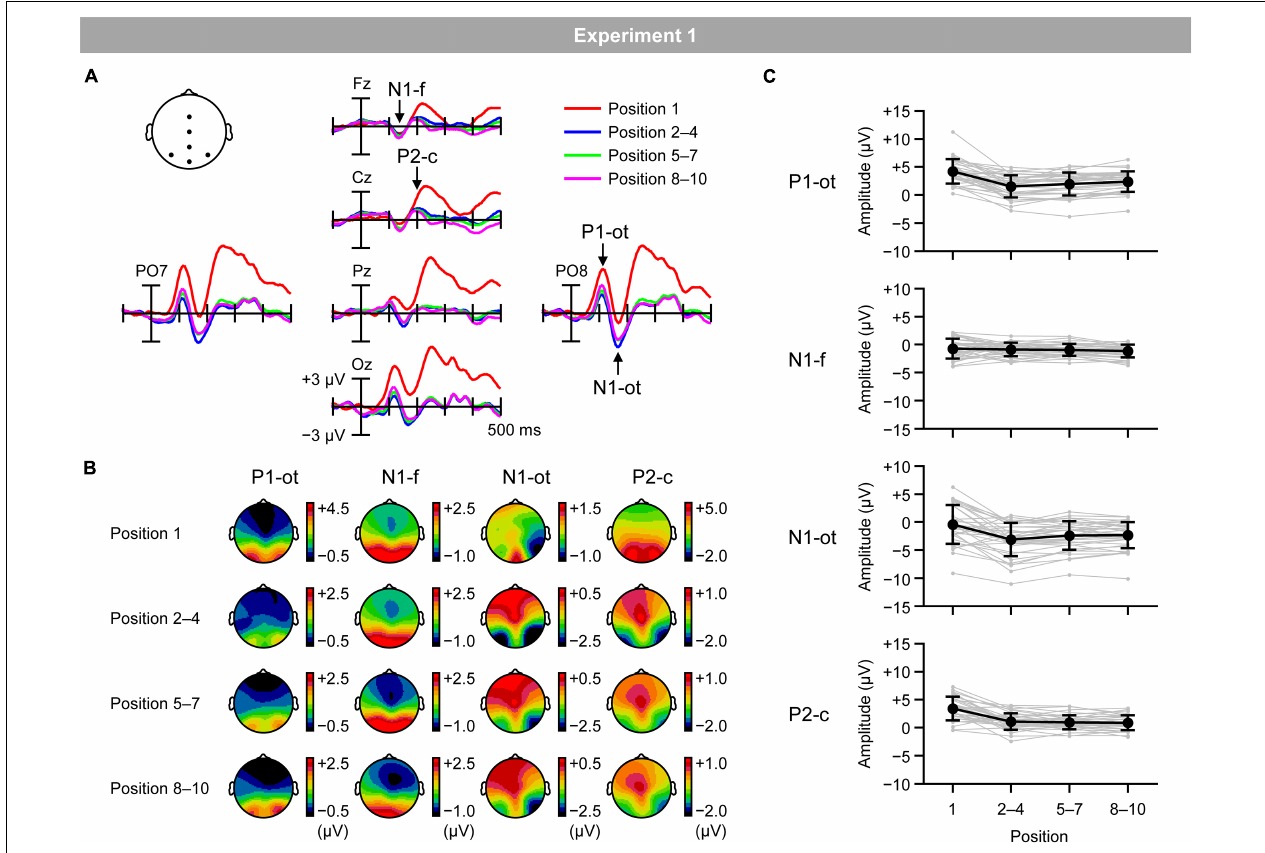
FIGURE 4 | (A) VEPs elicited by inducing stimuli presented at the first position (red lines), second, third, and fourth positions (blue lines), fifth, sixth, and seventh positions (green lines), and eighth, ninth, and tenth positions (purple lines) in the regular trials. (B) Topographical maps of VEPs. (C) Mean (black) and individual (gray) magnitudes of VEPs. P1-ot: occipito-temporal P1, N1-f: frontal N1, N1-ot: occipito-temporal N1, P2-c: central P2. Error bars indicate SD